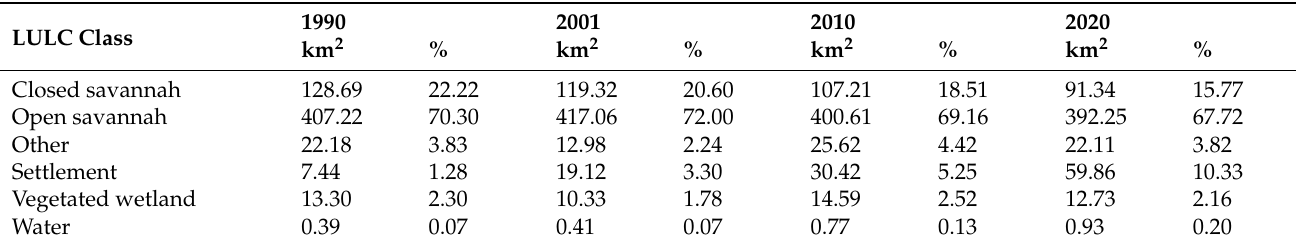
Table 4. Spatial changes of land area for the land use and land cover classes in Wa Municipality for the 1990, 2001 2010 and 2020 time series.